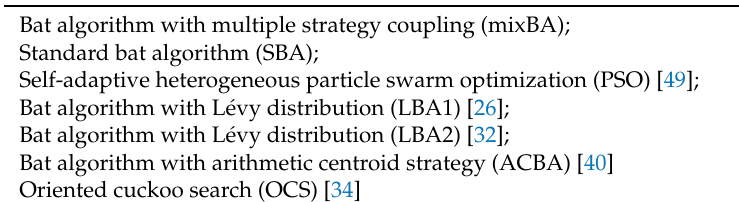
Table 4. The involved